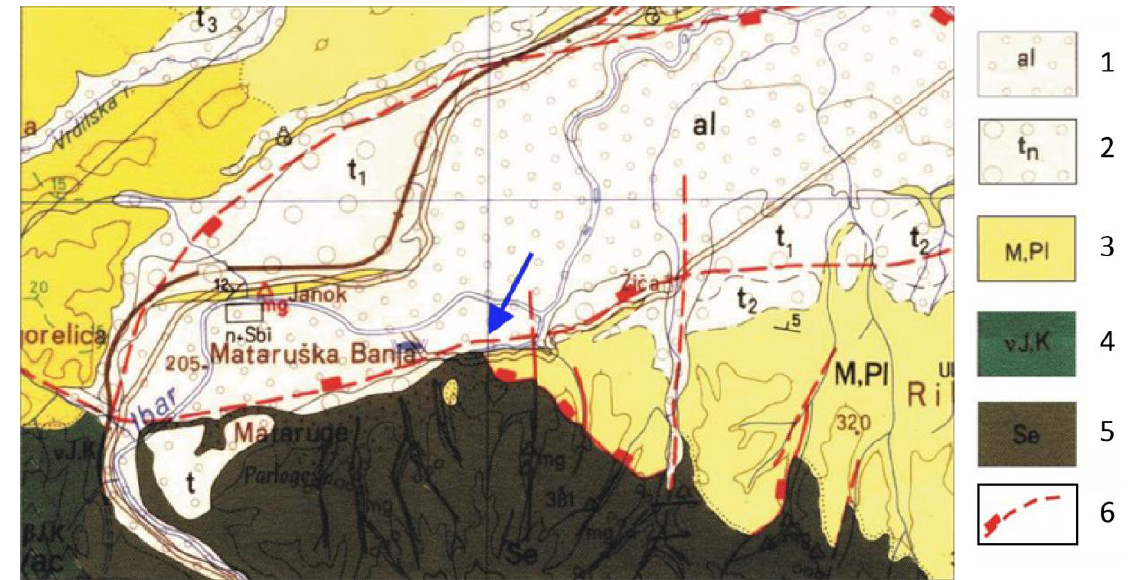
Figure 2. Basic Geological Map of Kraljevo City, 1:100 000 - an excision (after Marković et al . 1963); Blue arrow is showing Lojanik hill: 1. alluvium; 2. river terraces; 3. clastites, limestones, clays with coal (Pannonian and Pontian); 4. gabbros; 5. serpentinized peridotites; 6.